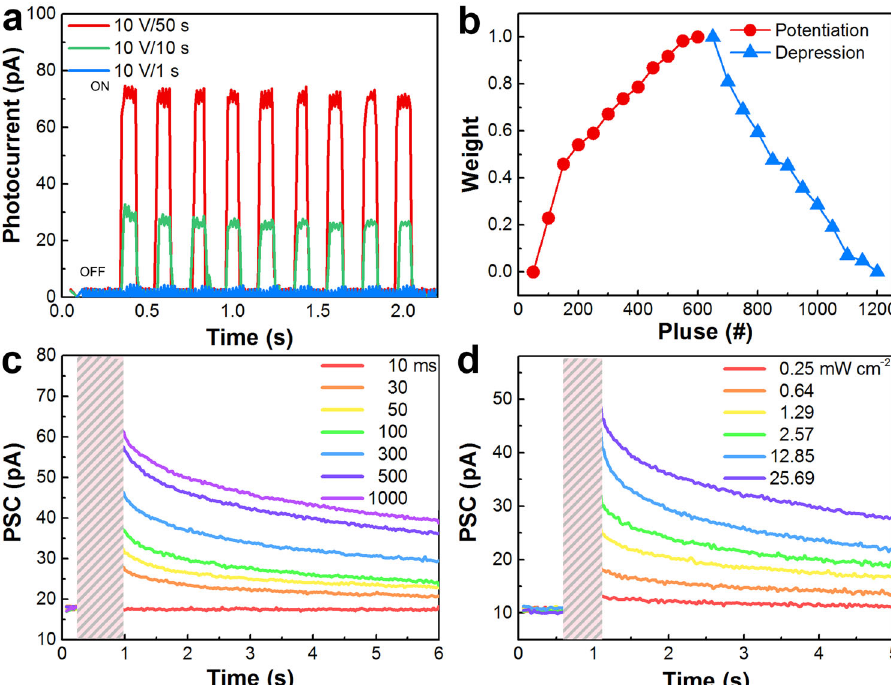
Fig. 5 The optical synaptic behavior of the MF/CuPc interfaces. a Self-driven photocurrents after poling at 10 V with different pulse duration. b Synaptic weight or conductance of the interfaces regulated by the numbers of the voltage pulses. The red line represents potentiation responses after stimulation by + 10 V pulses, while the blue represents depression after stimulation by − 10 V pulses. Transition from STP and LTP can be obtained by increasing the light pulse width ( c ) or intensity ( d